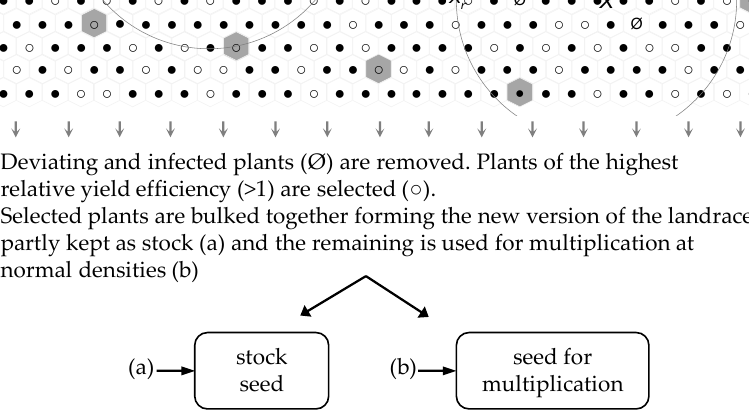
Figure 3. A pilot scheme of the landrace bulk breeding involves the evaluation of about 2000 individual plants at an ultra-low density approaching nil -competition and the selection of 500–700 plants, ultimately culminating with upgraded seed to be used as stock ( a ) and the beginning of a multiplication round ( b